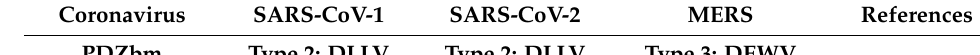
Table 2. PDZ interactors with the E protein of the most pathogenic